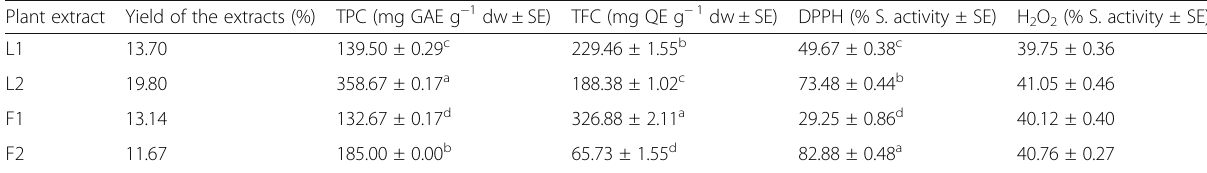
Table 1 Quantitative estimation of total phenolic, total flavonoid and free radical scavenging activity by DPPH and H 2 O 2 assays in aqueous and methanolic extracts of leaves and flowers of Saussurea obvallata